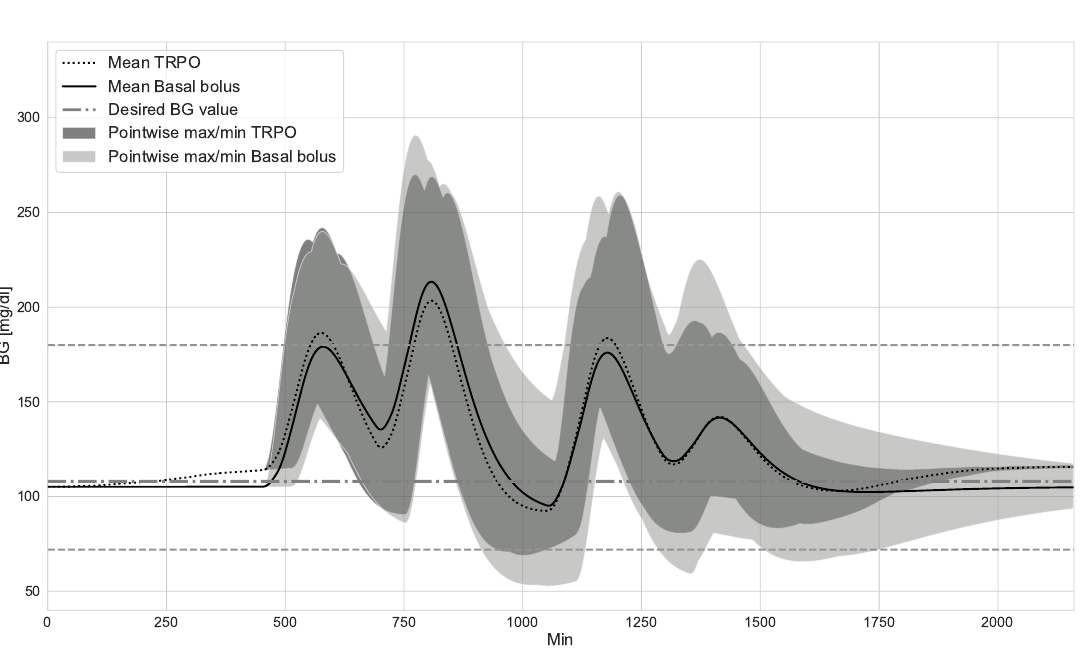
Figure 4. Blood glucose levels of Trust-region policy optimization (TRPO) reinforcement learning (RL) agent and standard basal-bolus therapy for the Hovorka patient. The dashed and continues curves represent the average blood glucose values over 100 test meal scenarios for the TRPO agent and the basal-bolus regimen, respectively. The shaded dark and light gray envelopes represent the minute-wise maximum and minimum blood glucose level of the simulation for the TRPO agent and the basal-bolus regimen respectively. Each test episode runs for one and a half day, a total of 2160